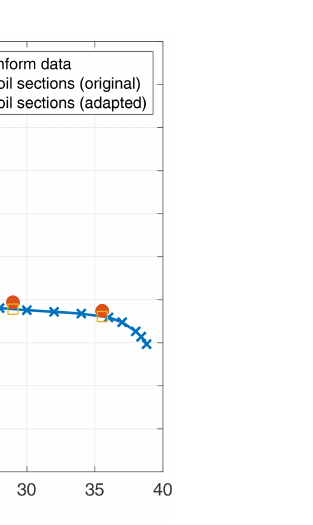
Figure B3. Thickness distribution of DANAERO blade according to the planform data and the original and adapted airfoil sectional data. The discrepancy explains the observed sensitivity of the force at Sect. 3 towards the lift coefficient at Sect. 4.